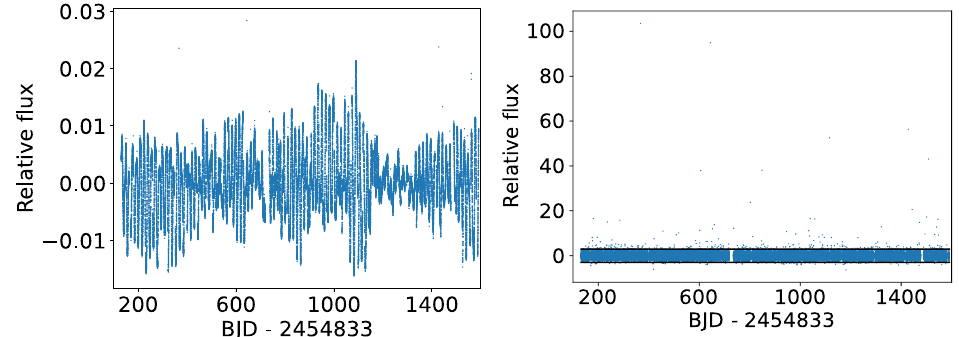
Figure 1. The left panel is the original light curve (after applying the pre-processing only necessary for Kepler as discussed in Section 2.2) and the right panel is the smoothed light curve after subtracting by the “F8” smoothing filter. The Kepler long-cadence PDC flux data used in both panels is from KIC 9017220. In the right panel, the two horizontal black lines represent the 3-sigma uncertainty range. In our smoothness metric, we define points > ± 3-sigma as outliers and then examine whether the outliers exhibit any periodicity.